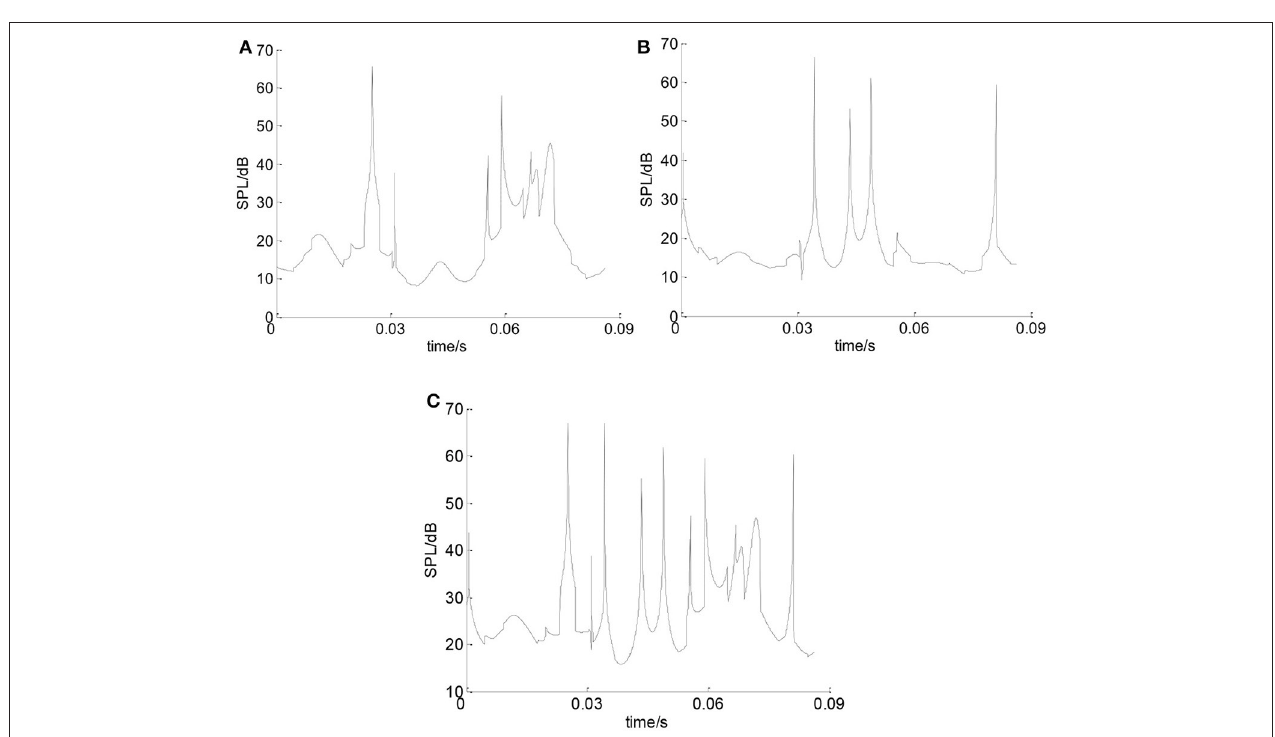
FIGURE 13 | The SPL of the balls. (A) SPL of the balls in X direction. (B) SPL of the balls in Y direction. (C) Total SPL of balls.